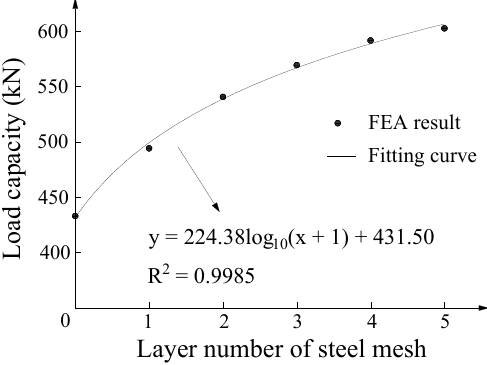
Figure 17. Effect of layer number of steel mesh. Table 4. Improvement proportion caused by increasing layer number of steel mesh.